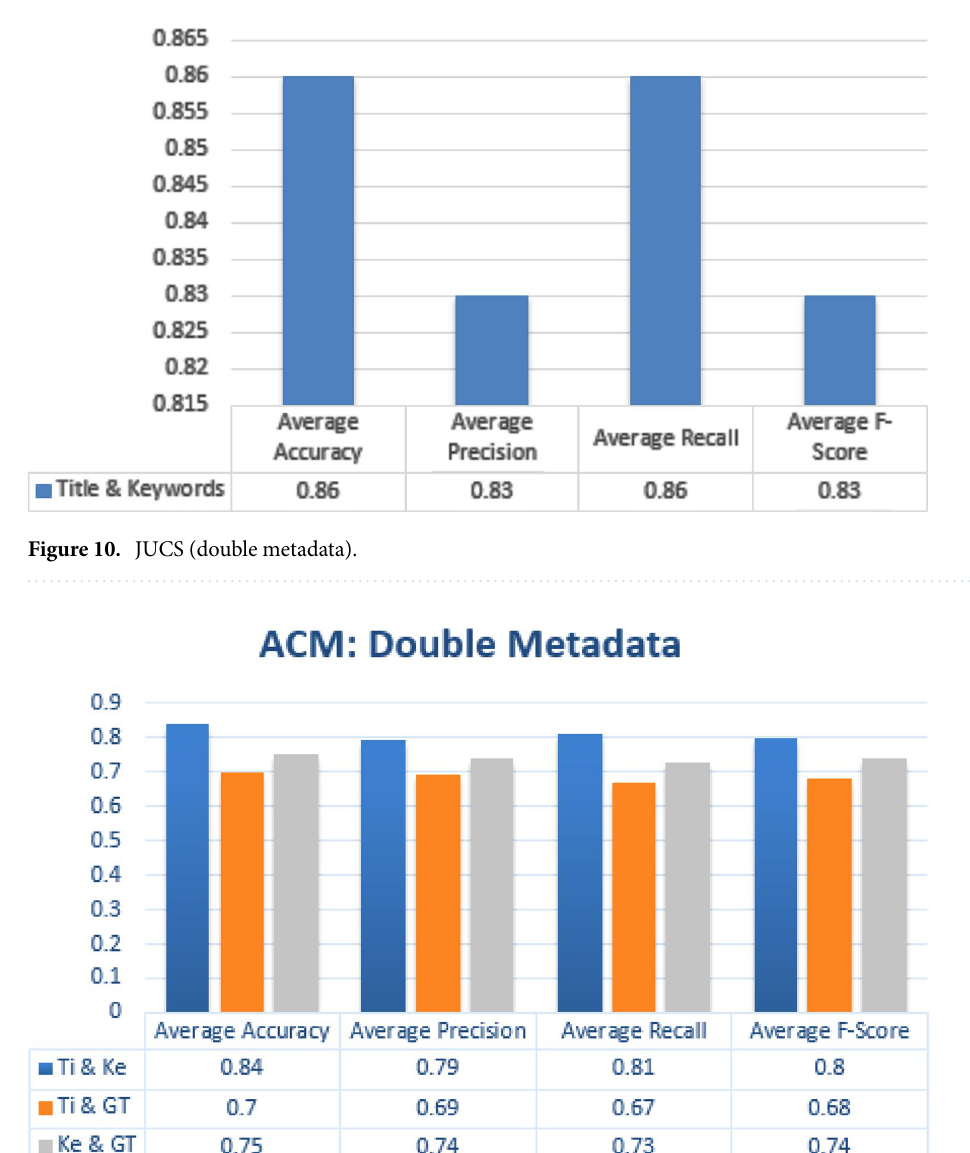
Fig. 10. In case of ACM datasets there are three double metadata parameter combinations “Title + Keywords”, “Title + General Terms” and “Keywords + General Terms”. The “Title + Keywords” combination outperformed other combination with the average Accuracy of 0.84, average precision of 0.79, average Recall of 0.81 and aver- age F1-measure 0.8. The second top scored combination is “Title + General Terms” and the third one is “Key-